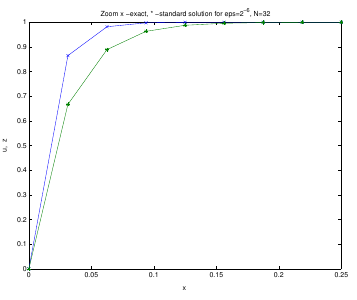
Figure 1. Zoom × - exact solution, ∗ - standard solution for ε = 2 − 6 , N = 32